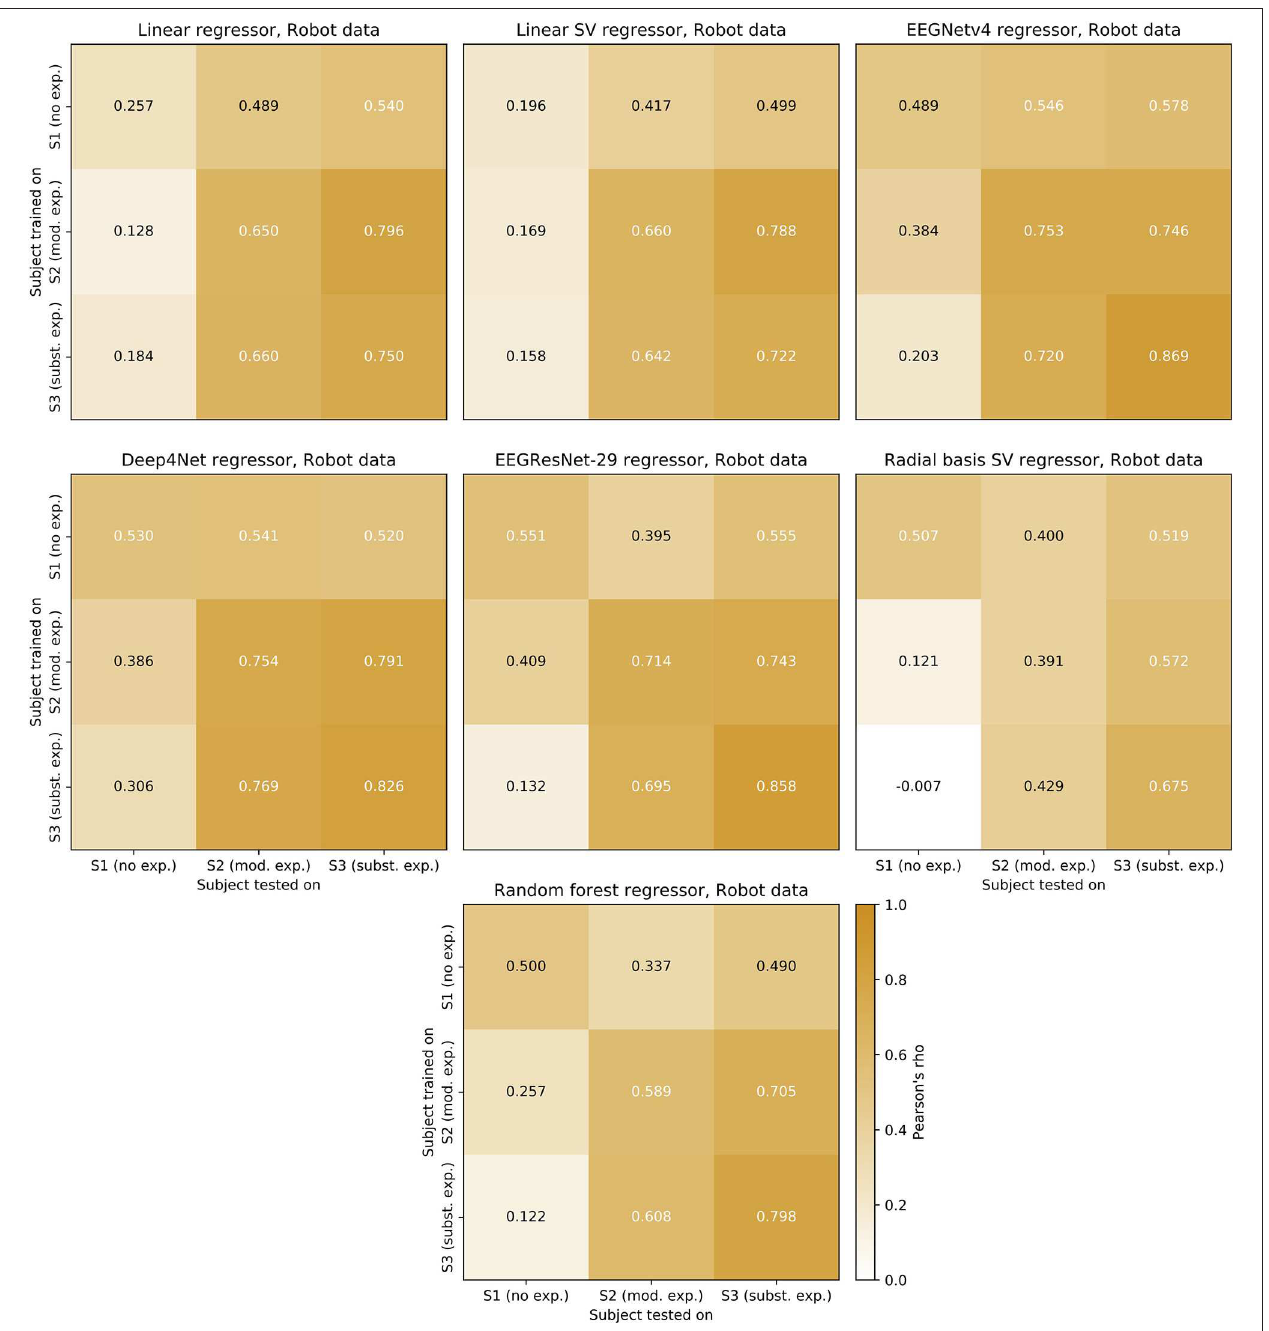
FIGURE 10 | Across-user transfer matrices. Regression across users trained on the position of the robotic hand. As test-set, the last 3 min of the experiment was used for each user. The transfer matrix displays the user on which the regressor was trained (y-axis) and the user on which it was evaluated (x-axis). The evaluation metric (Pearson’s ρ ) is displayed color-coded and in text within the respective